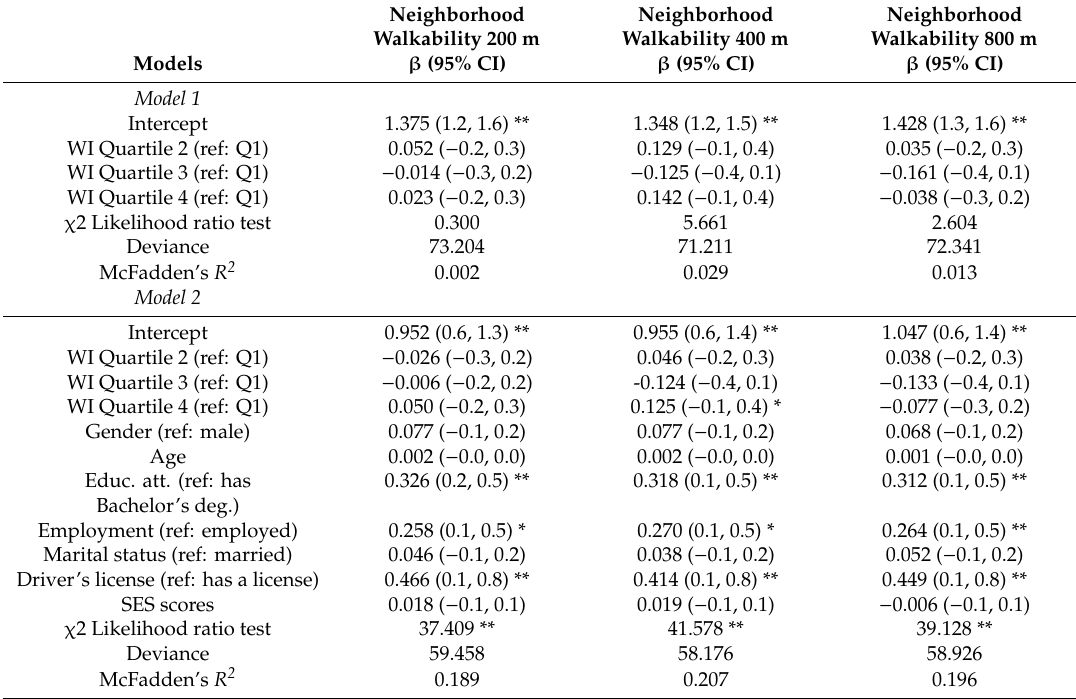
Table 3. Results of the gamma generalized linear models (GLM) for time spent looking at screens.